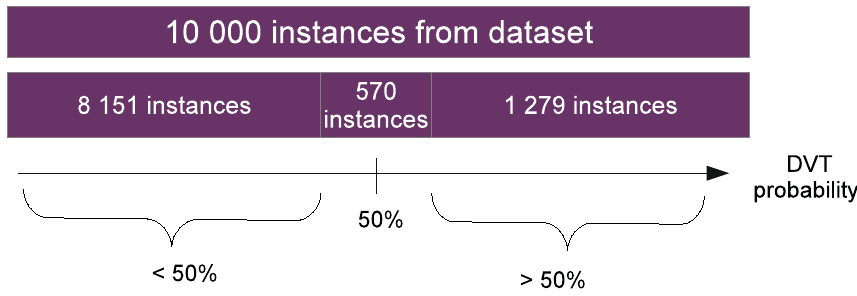
Figure 4. Representation of the training dataset.